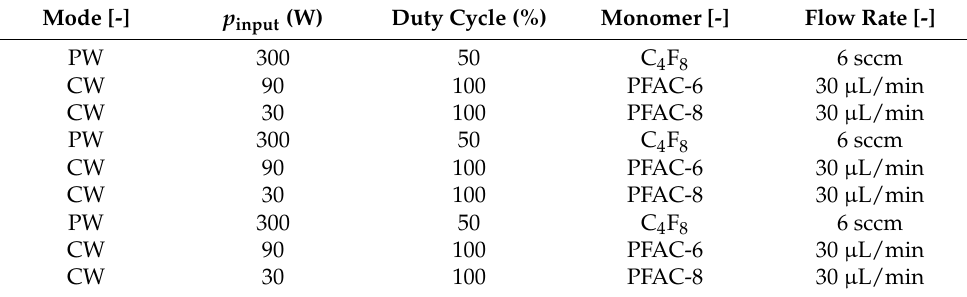
Table 2. Process modes used for plasma polymerization of different